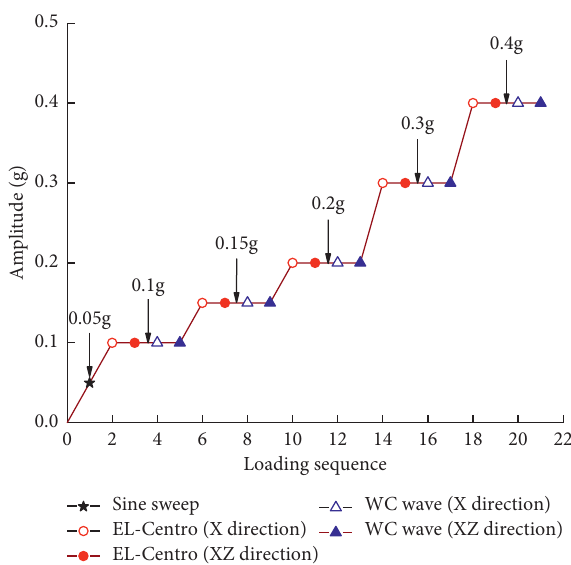
Figure 5: Loading sequence and